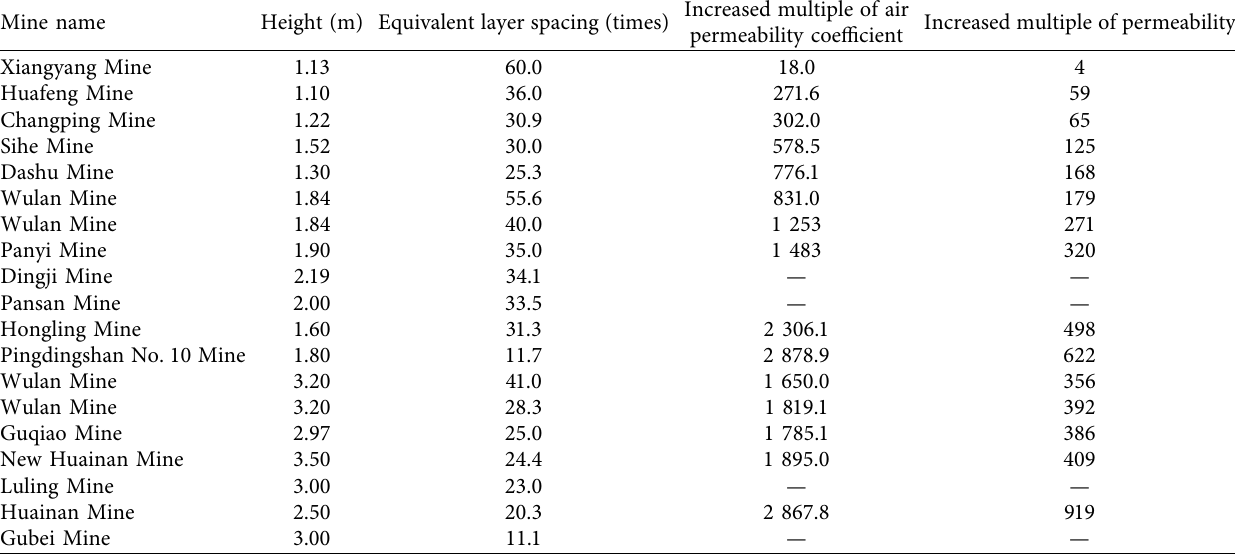
Table 1: Protection effect of a protective layer with different mining heights [13–30].